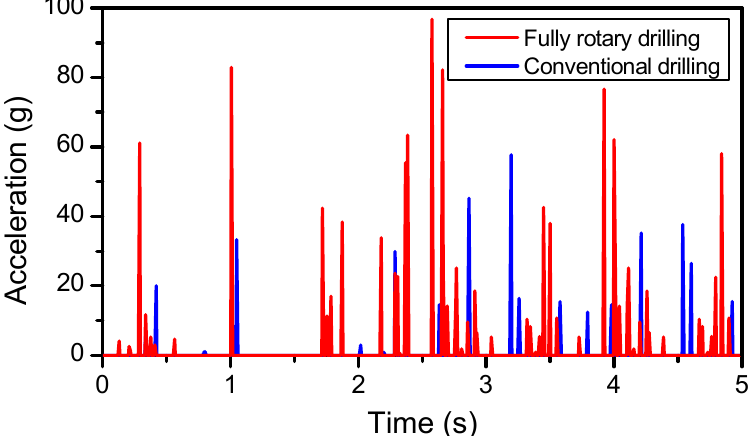
Figure 4. Impact force versus time between drill pipe and wellbore for both fully rotary and conventional drilling.